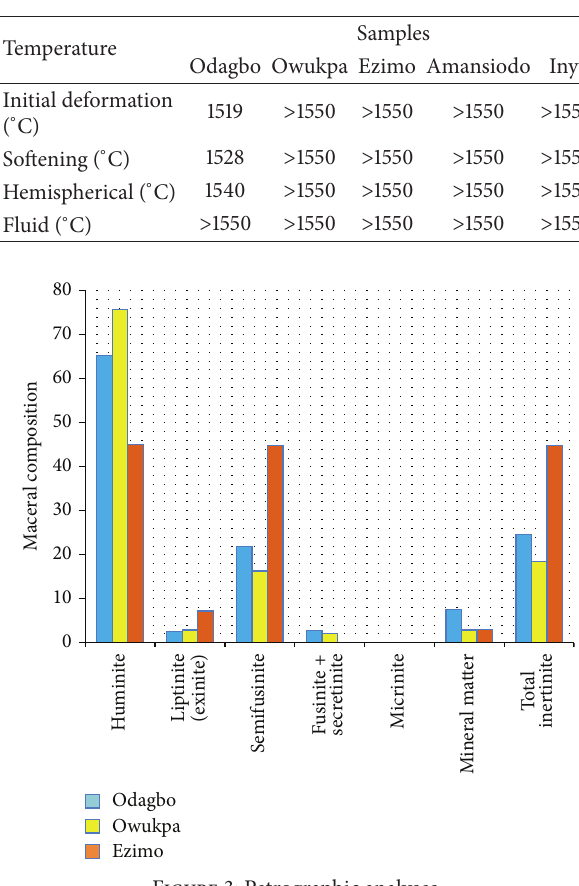
Figure 3. Based on the conclusion of [18] that a fuel with